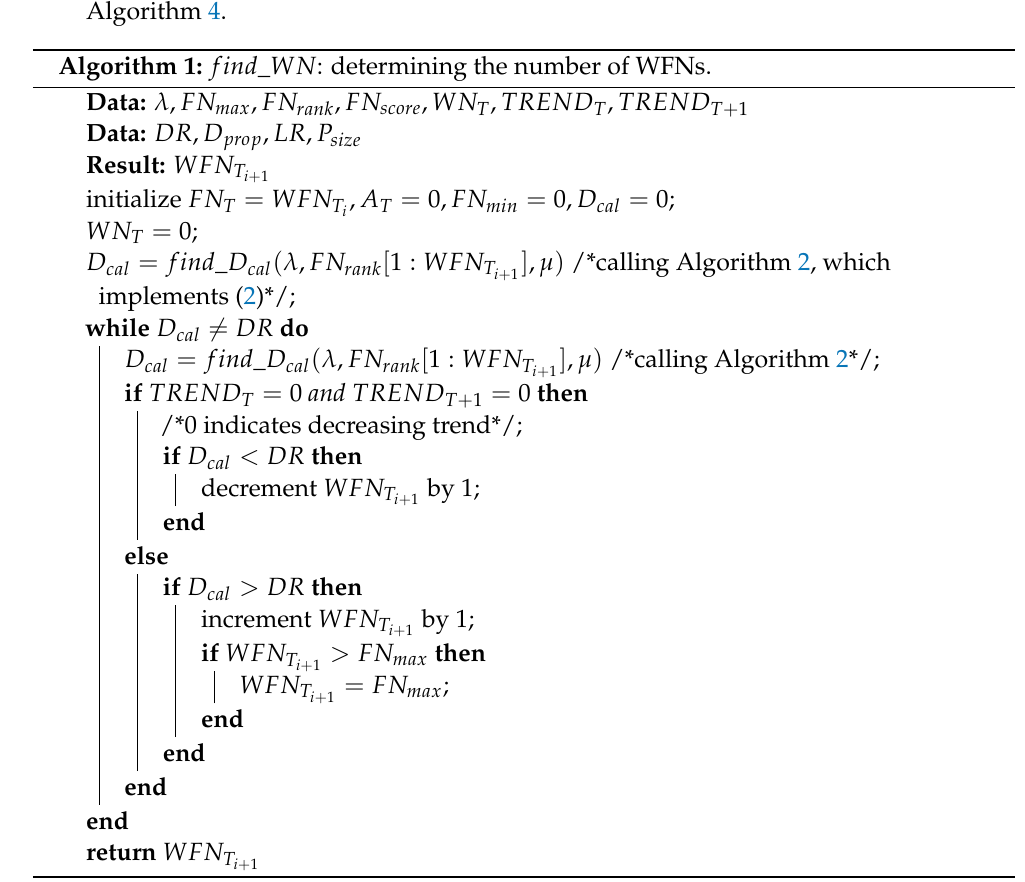
Algorithm 1: f ind _ WN : determining the number of WFNs.